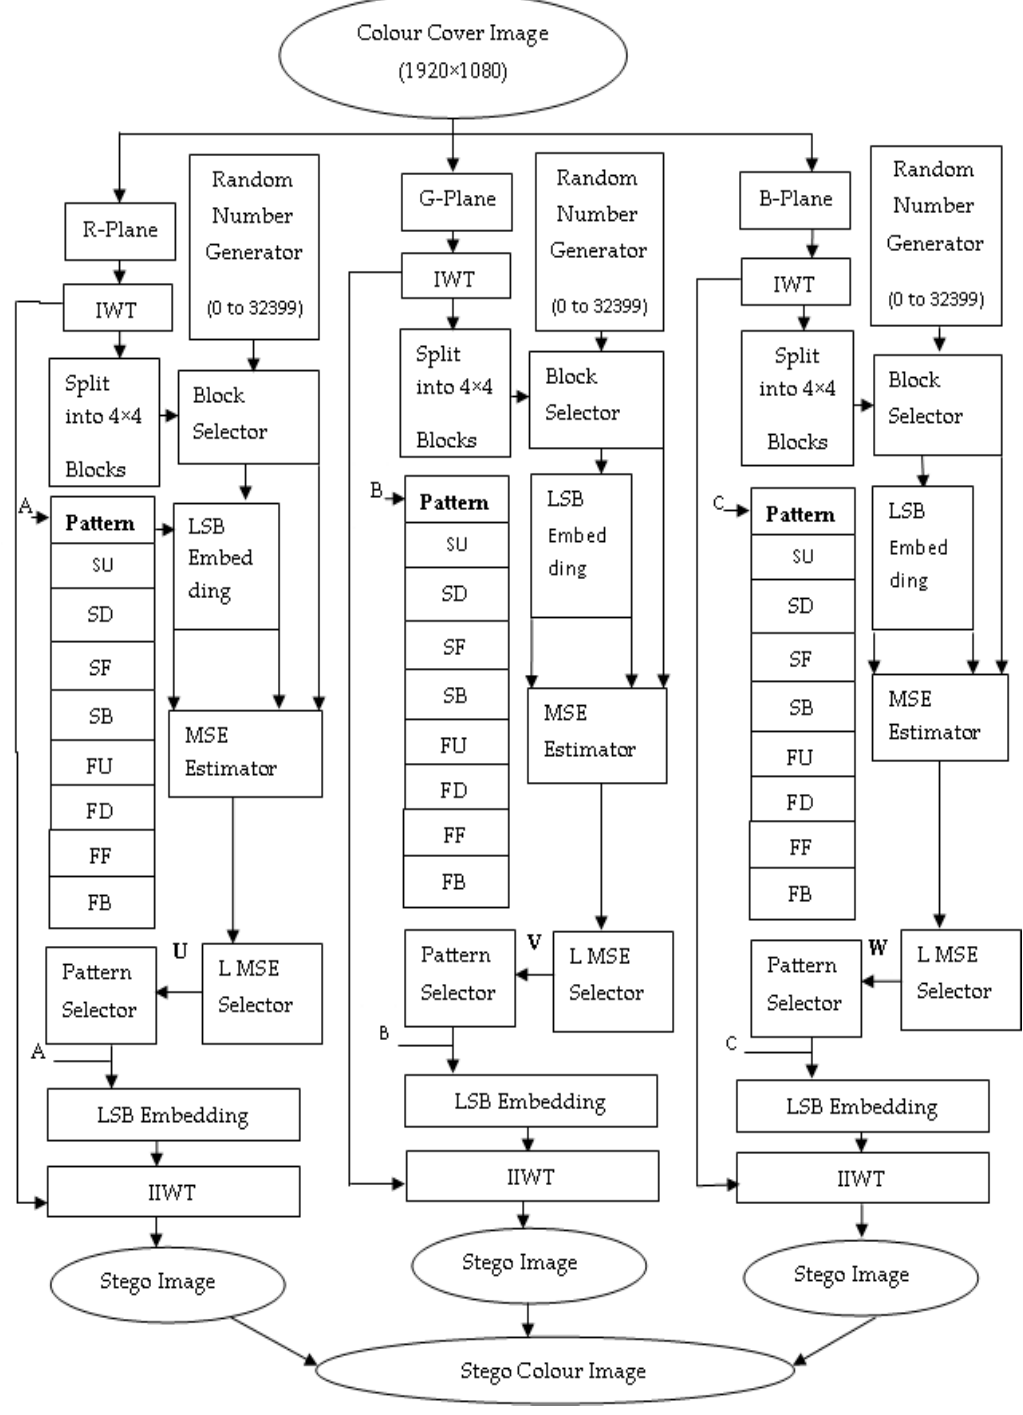
Figure 5. Flowchart representation of the embedding algorithm.